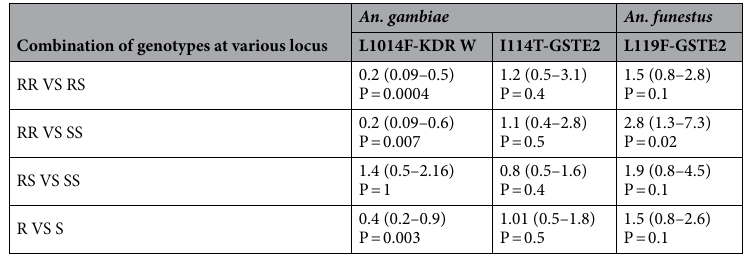
Table 1. Association between pyrethroids resistance markers and resistance to chlorfenapyr in.